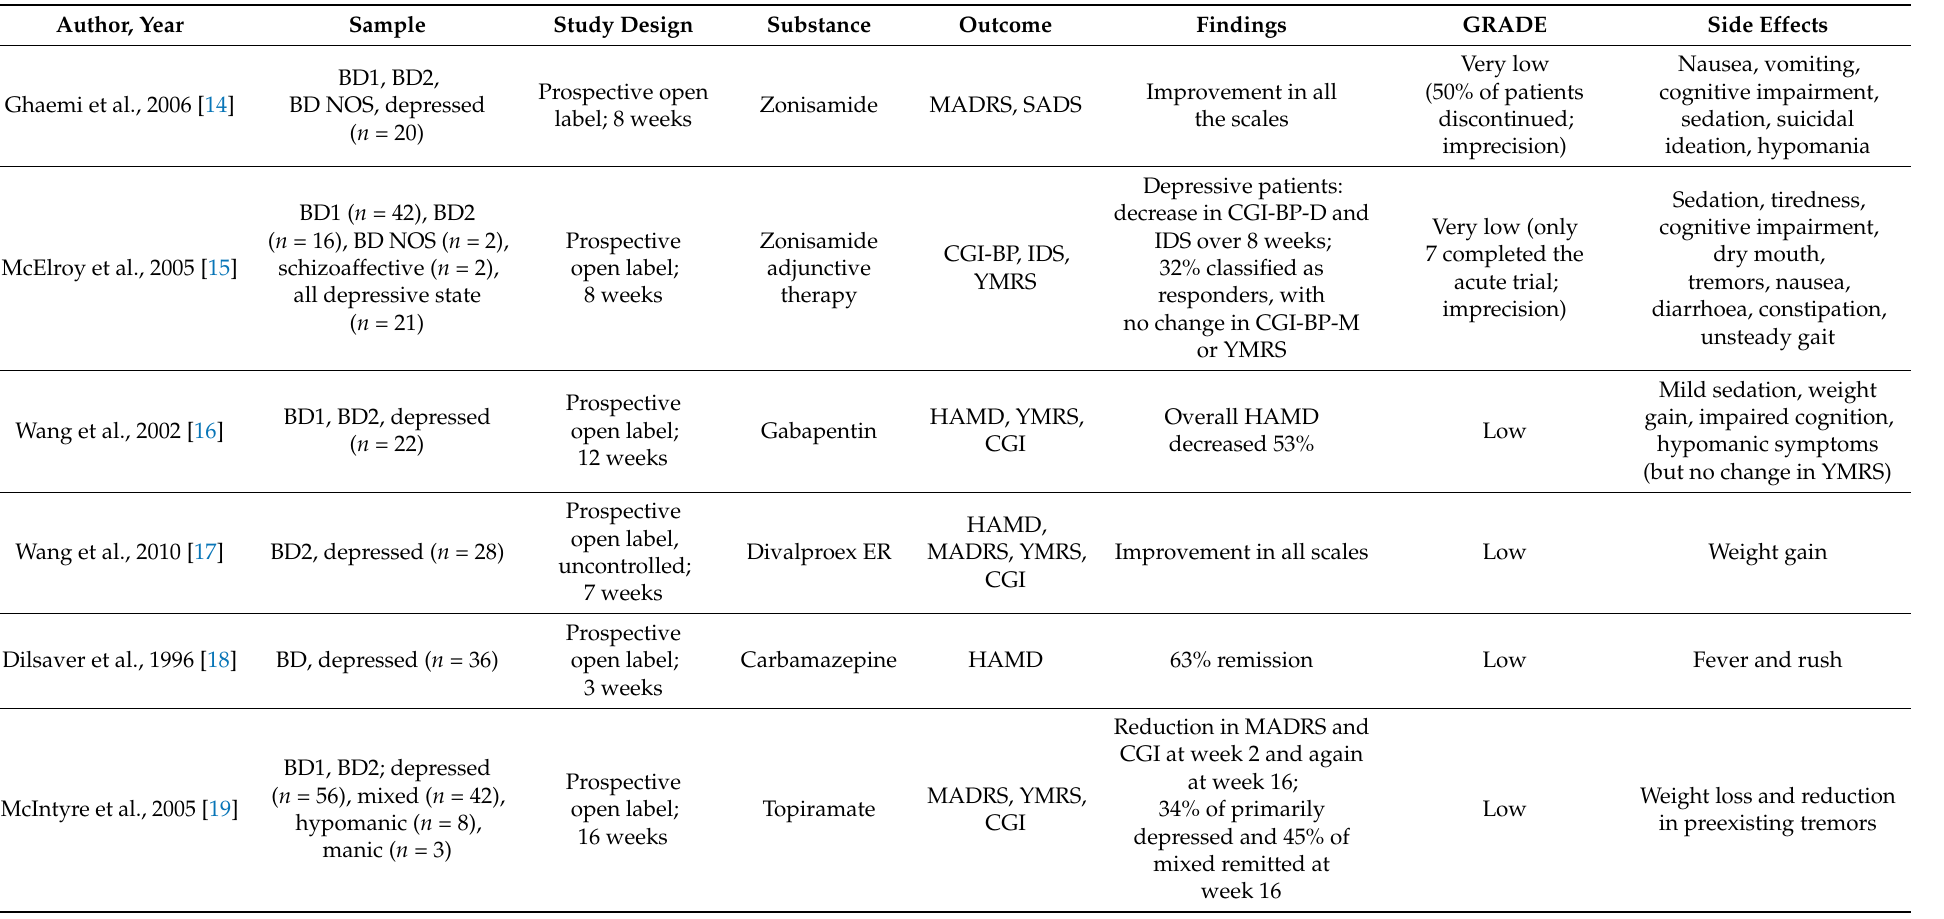
Table 1. Observational studies on anticonvulsants in the treatment of bipolar